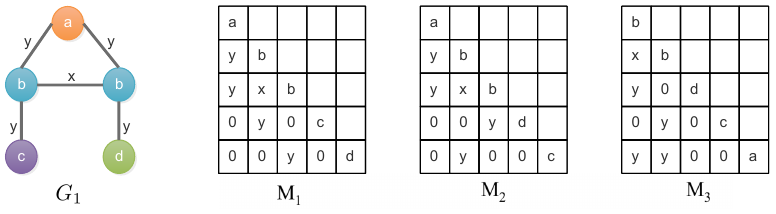
Figure 3. Three adjacency matrices M 1 , M 2 , and M 3 for the graph G 1